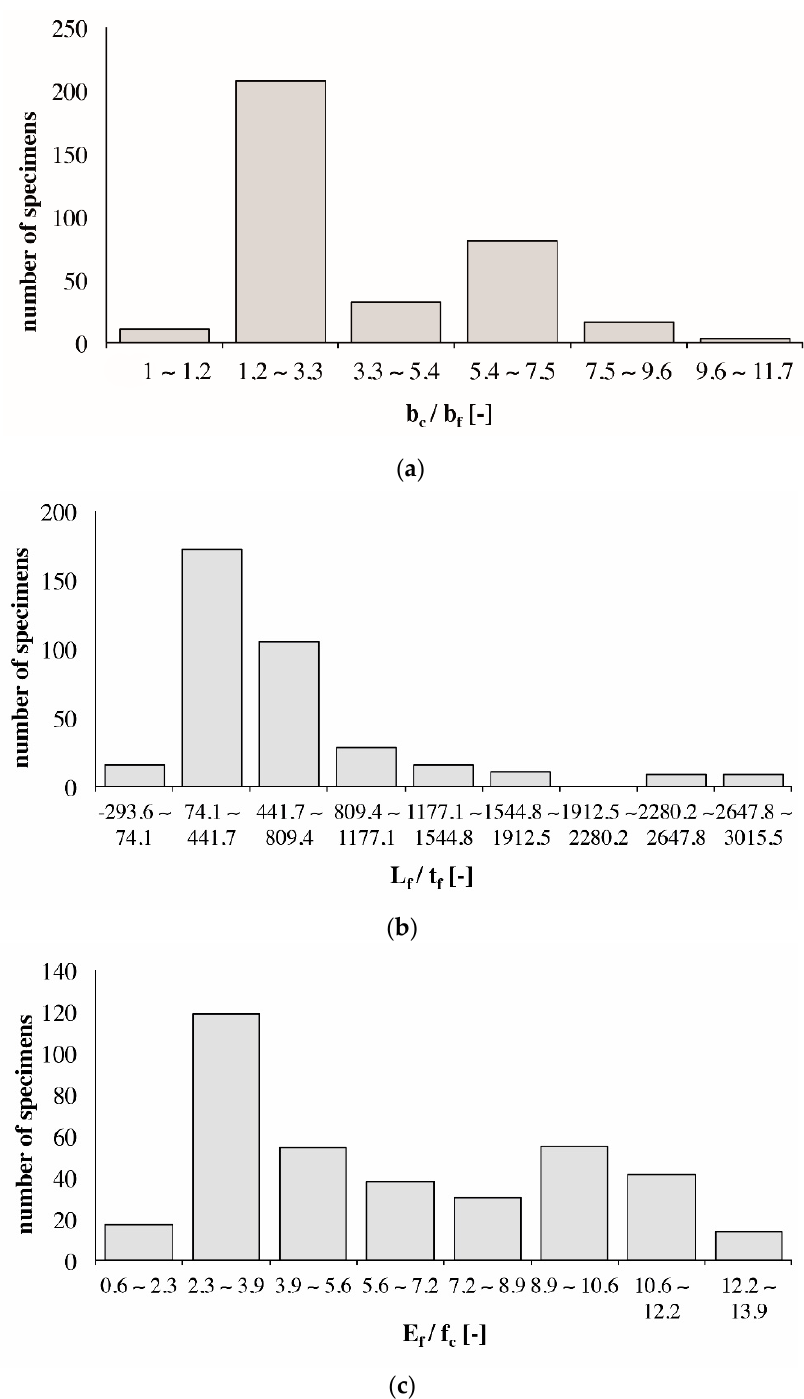
Figure 4. Distribution of data in terms of input parameters: ( a ) β , ( b ) γ and ( c ) δ . A non-linear input-output model was implemented with a polynomial active neuron type in a 3-hidden-layers network. The generated model is listed from Equations (7)–(13). As evident, α was computed by a sequence of polynomial simple equations in which x variables are processed from the characteristics of the specimen expressed through β , γ and δ .